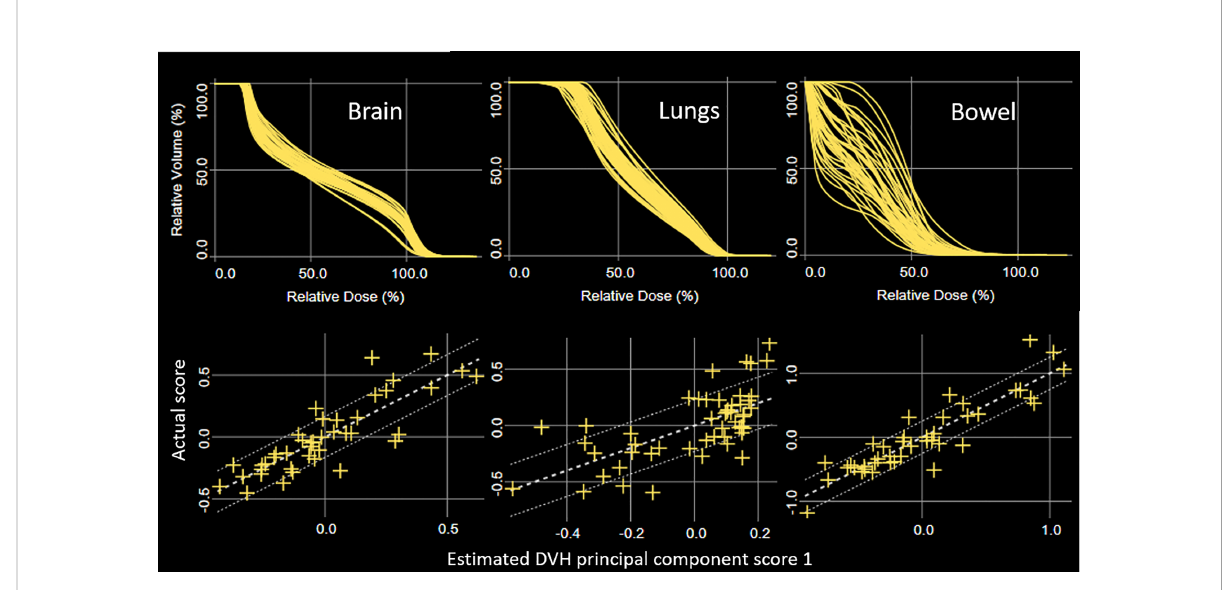
FIGURE 2 DVH plots (top) and principal component scatter plots (bottom) for brain, lungs, and bowel in the HN, chest, and pelvis models, respectively. Con fi dence intervals are displayed using one standard deviation of fi tting error